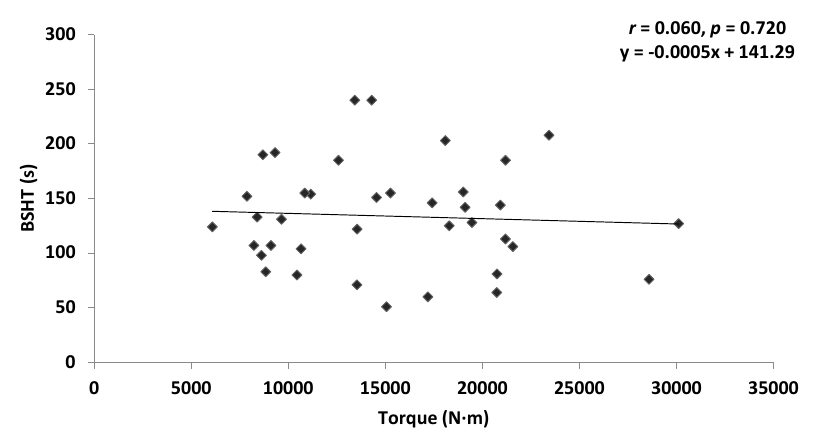
Figure 5. Scatter plot of asymptomatic data for ILEX strength (SI) and TEX endurance (BSHT).